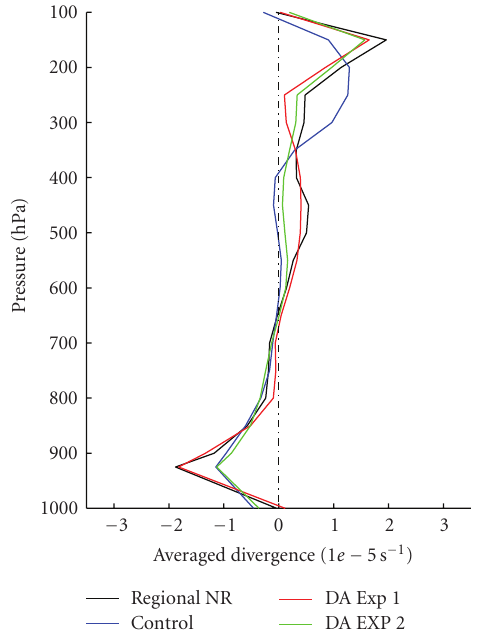
Figure 5: Area-averaged divergence vertical profiles over the area with radius of 250km around the storm center at 0600 UTC 01 October 2005 (black line: regional nature run; blue line: control run; red line: data assimilation Experiment 1; green line: data assimilation Experiment 2).